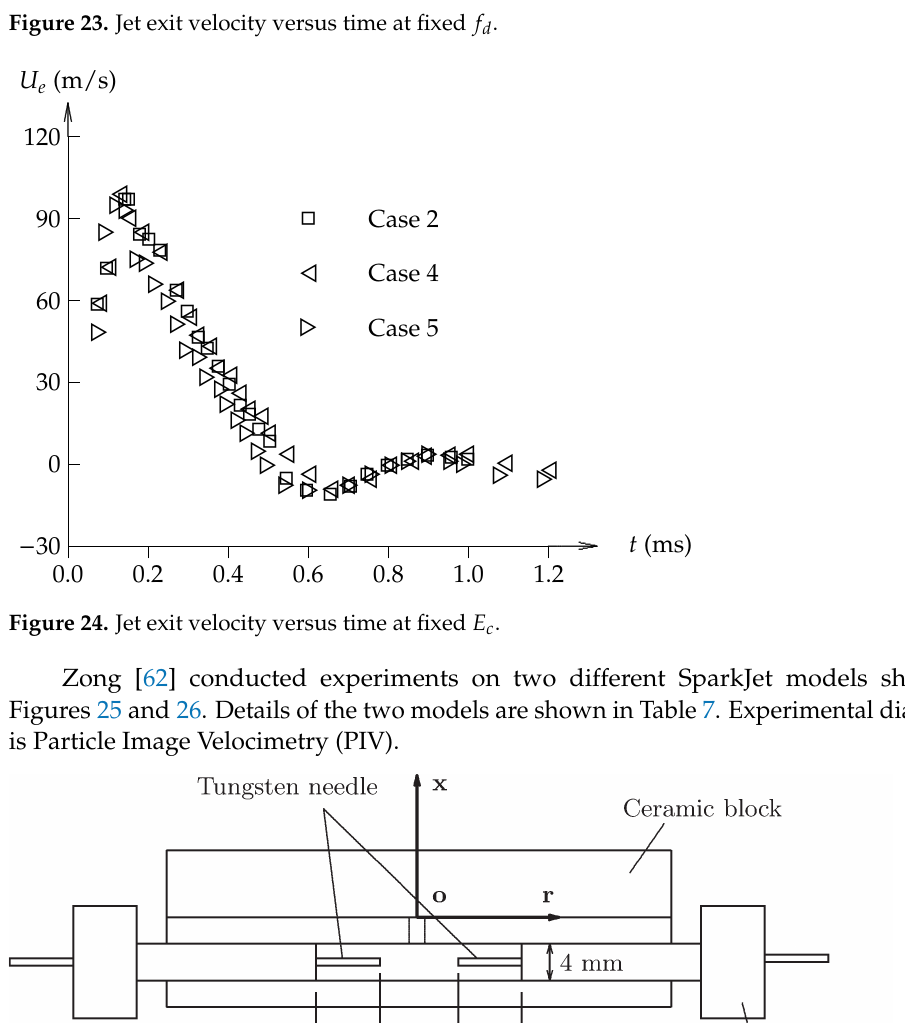
Figure 27. Small cavity model. Adapted from [62].